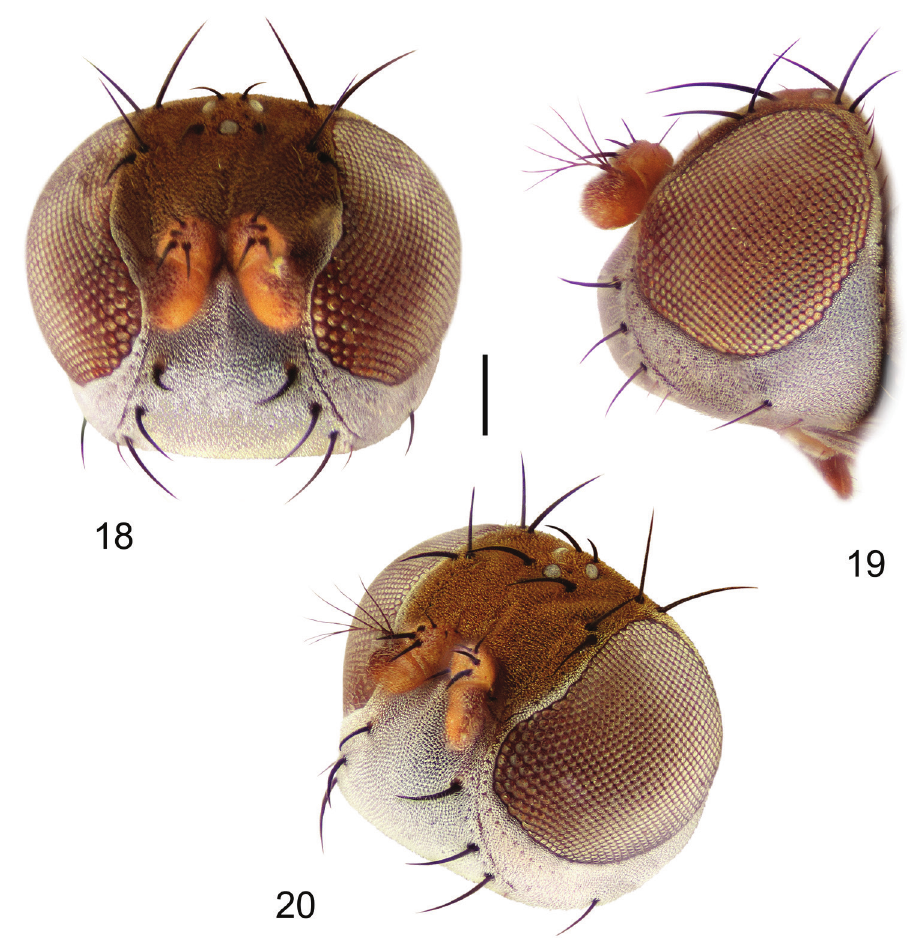
Figures 18–20. Hydrochasma faciale (Williston) (St. Vincent. St. Patrick: Cumberland Bay) 18 head, anterior view 19 same, lateral view 20 same, oblique view. Scale bar = 0.1